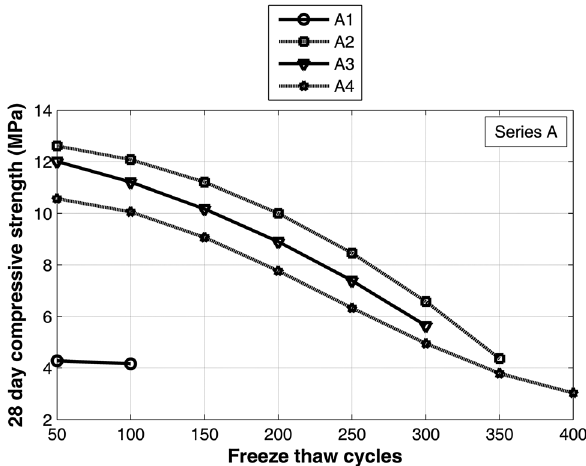
Fig. 8 Compressive strength at 28 days for series A during freeze thaw cycles.